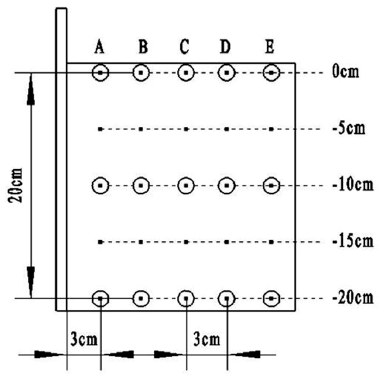
Figure 8. ST-SWC test layout. Note: The large circle represents the soil water content(SWC) sensor position, and the small circles represent the soil temperature (ST) sensor